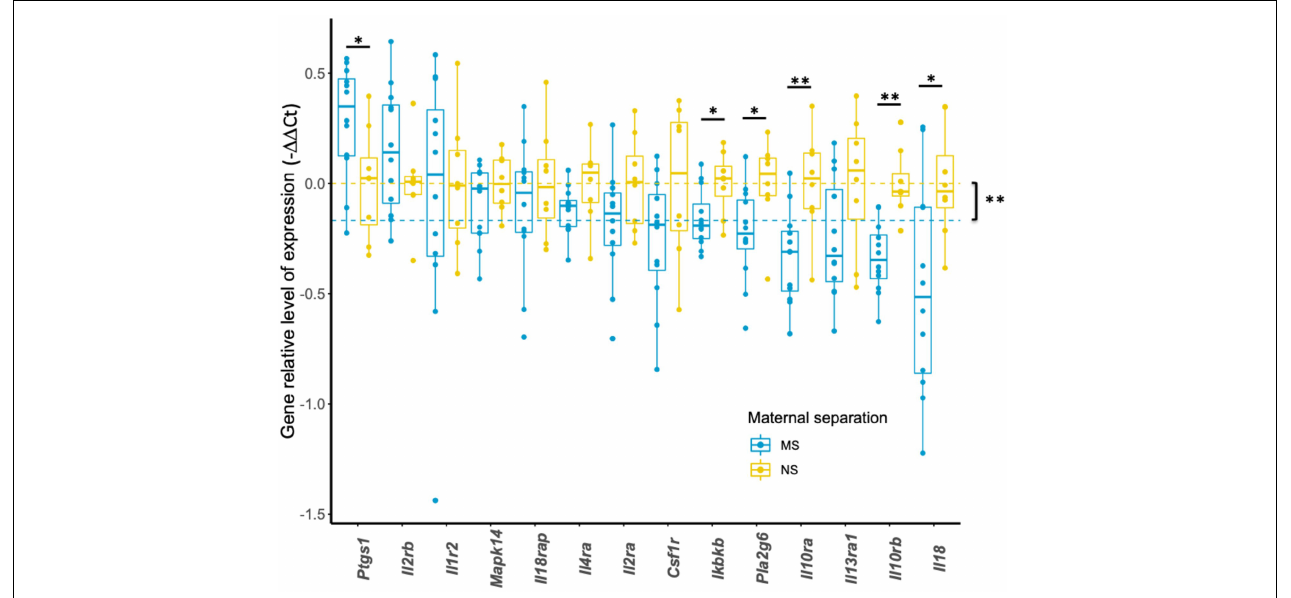
FIGURE 3 | Transcriptional expression of HRRI candidate genes in adolescent mice. Total RNA from blood of NS and MS mice at P60 was profiled by RT-qPCR for 14 HRRI candidate gene transcripts. The expression of each transcript was quantified relative to the expression of a reference gene, Rab5a , whereas the mean of NS mice was used as a calibrator. Statistical analysis was realized using a permutation-based non-parametric factorial ANOVA. Yellow and blue dashed lines indicate the mean values of all NS and MS, respectively, and highlight a significant “gene” effect between NS and MS animals ( p = 0.00295). Significant multigroup comparisons for each gene were performed by pairwise permutation t -tests and are as follows, Ptgs1 ( p = 0.022), Ikbkb ( p = 0.028), Pla2g6 ( p = 0.022), Il10ra ( p = 0.008), Il10rb ( p = 0.002), Il18 ( p = 0.032). * p < 0.05; ** p <